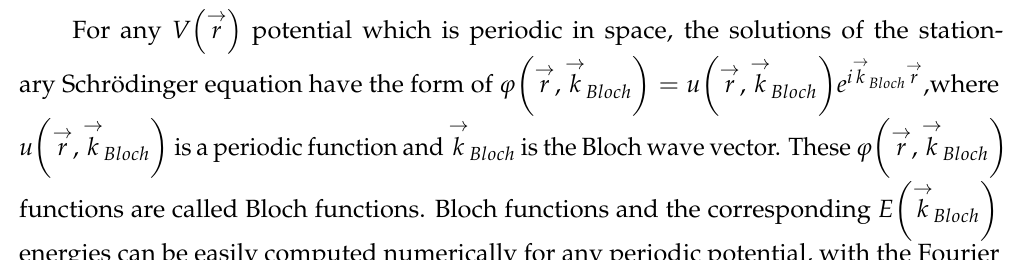
(cid:18) (cid:19) → → → k Bloch → r . Middle column: u r , k Bloch . Right column: